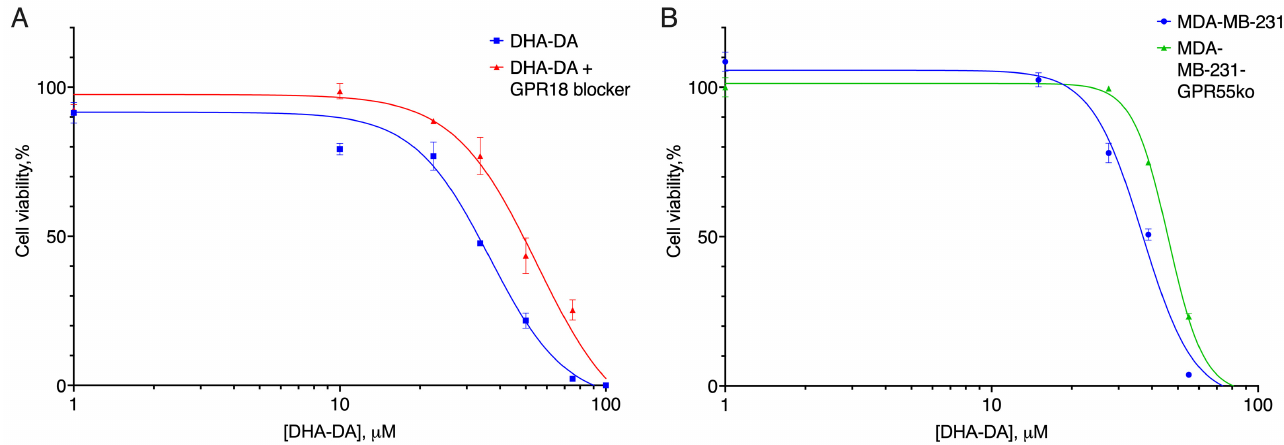
Figure 12. GPR18 ‐ GPR55 interaction in the DHA ‐ DA cytotoxicity. ( A ) Cytotoxicity of DHA ‐ DA for the original line MDA ‐ MB ‐ 231 with and without the GPR18 blocker PSB CB5 (3 μ M). ( B ) Cytotoxi ‐ city of DHA ‐ DA for the original line MDA ‐ MB ‐ 231 and the variants with knockout GPR55, incuba ‐ tion time 24 h, MTT test data. Pooled data from 7 experiments; mean ± standard error. Table 4. Cytotoxicity of DHA ‐ DA for the original cell line MDA ‐ MB ‐ 231, cells in the presence GPR18 blocker PSB CB5 (3 μ M) and the variant of with knockout GPR55, incubation time 24 h, MTT test